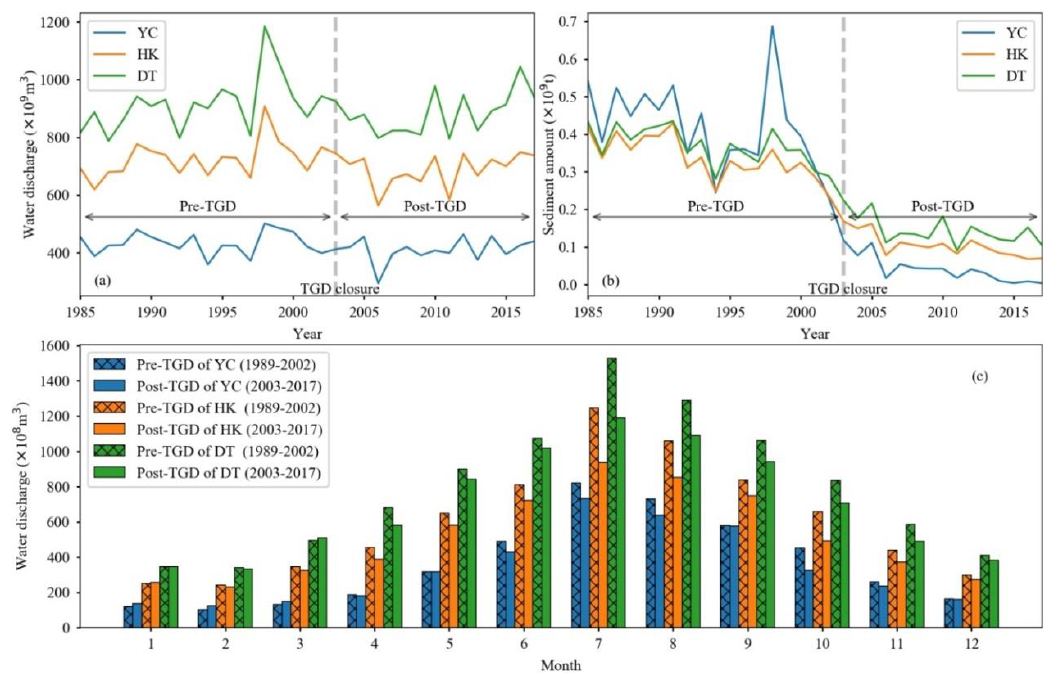
Figure 12. Flow and sediment regimes in the pre-TGD and post-TGD periods in the three key gauging stations. ( a ) Annual water discharge from 1985 to 2017, ( b ) Annual sediment amount from 1985 to 2017, and ( c ) Monthly averaged water discharge from 1989 to 2002 (Pre-TGD) and from 2003 to 2017 (Post-TGD).